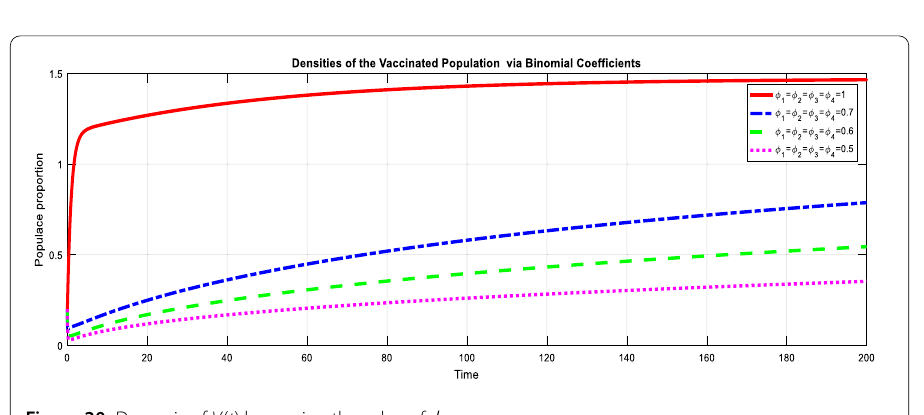
Figure 20 Dynamic of V ( t ) by varying the value of φ